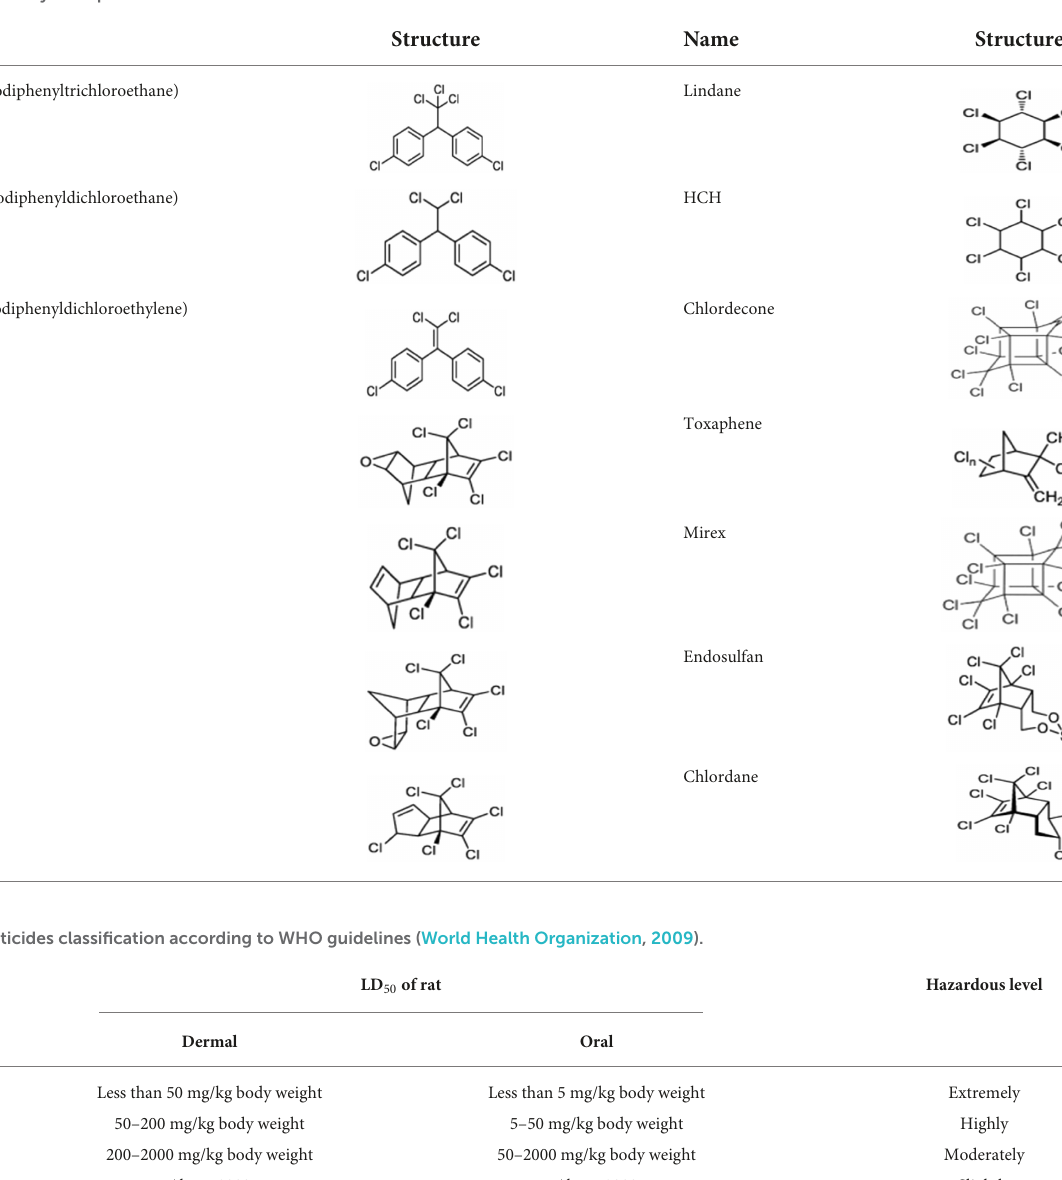
TABLE 1 Generally used pesticides and their chemical structures.